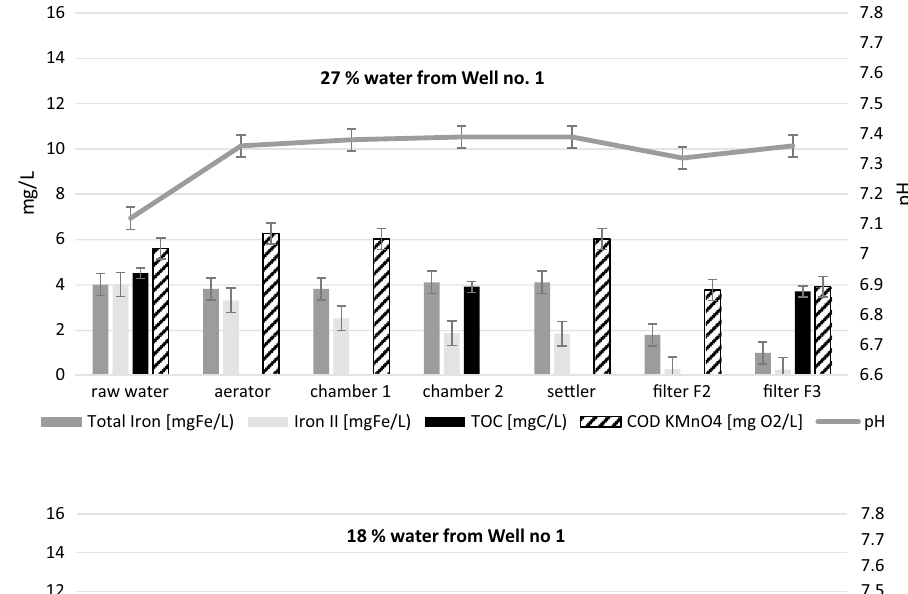
Fig. 7 Changes in the COD KMnO 4, TOC, iron and pH of mixed water from both wells with 27% of water from well no. 1 during its treatment in